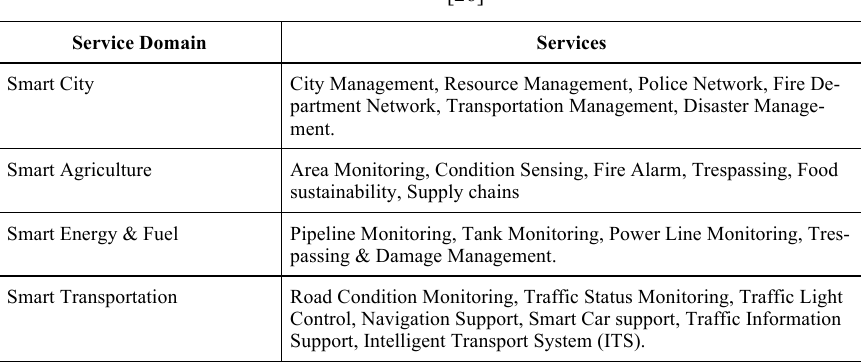
Table 1. IoT Smart Applications And Its Services [15][16][19] [20] [21] [22], [23] [24],